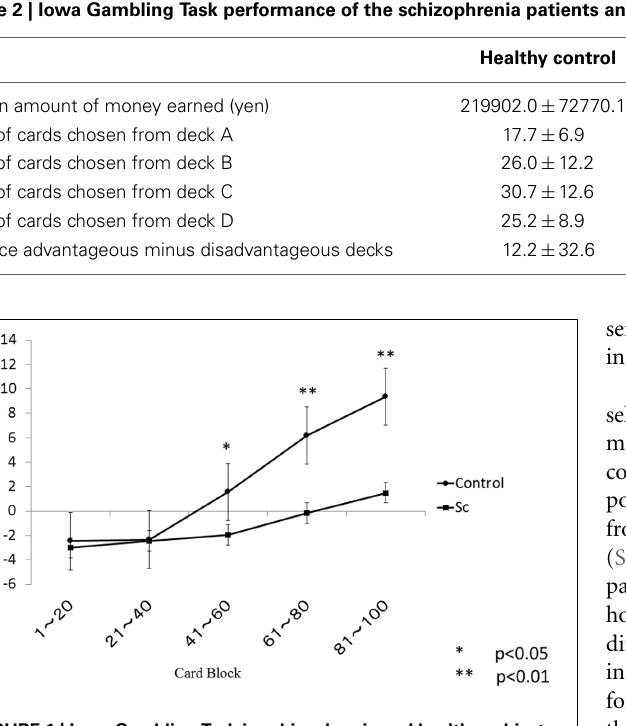
FIGURE 1 | Iowa Gambling Task in schizophrenia and healthy subjects.